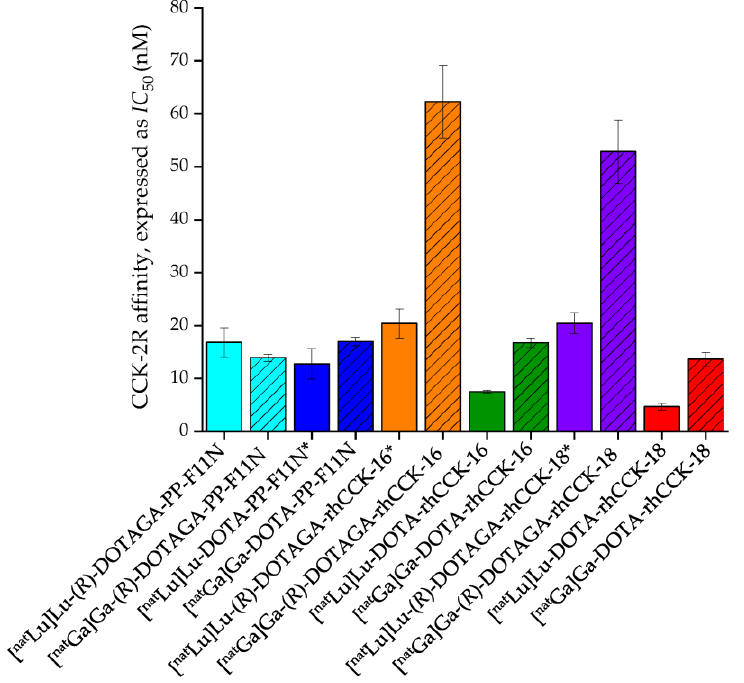
Figure 2. CCK-2R affinity (expressed as IC 50 ) of the reference compound DOTA-PP-F11N in com- parison to rhCCK-16 and -18 containing either a DOTA or ( R ) - DOTAGA moiety labeled either with [ nat Ga]gallium (hatched bars) or [ nat Lu]lutetium. IC 50 values were determined using AR42J cells (2.0 × 10 5 cells per well) and [ 177 Lu]Lu-DOTA-PP-F11N (0.3 pmol/well) as the radiolabeled reference (3 h, 37°C, RPMI 1640, 5 m M L-Gln, 5 mL non-essential amino acids (100×), 10% fetal calf serum (FCS) + 5% bovine serum albumin (BSA) ( v / v )). * data taken from Holzleitner et al. [19]. These data have been determined in our lab under identical conditions.